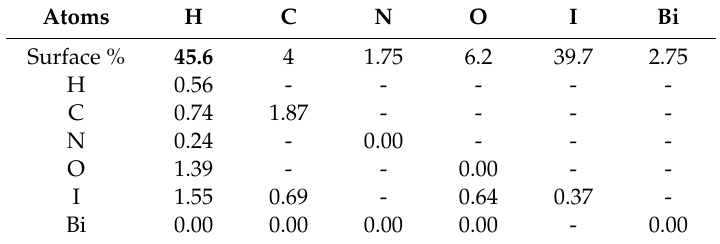
Figure 6. Fingerprint plots with d norm view of H ··· I, H ··· H, and H ··· O contacts in Bi 4 I 16 · 4(C 6 H 9 N 2 ) · 2(H 2 O). Table 4. Hirshfeld contact surfaces and enrichment ratios for Bi 4 I 16 · 4(C 6 H 9 N 2 ) · 2(H 2